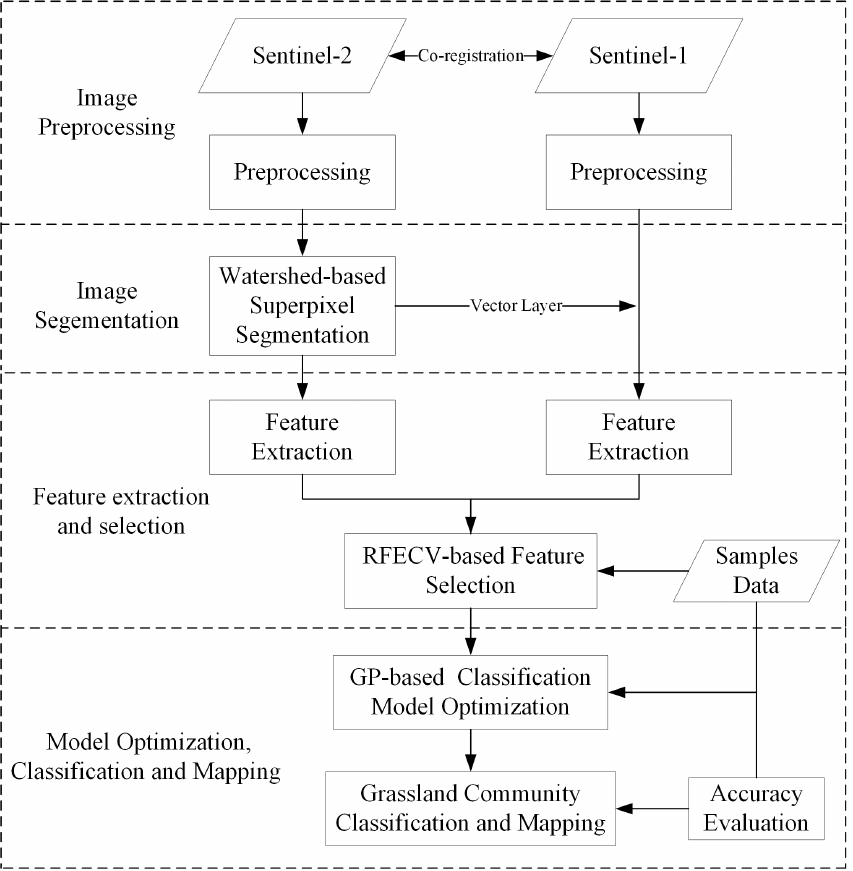
Figure 2. The flow chart of the proposed classification method for grassland communities in this